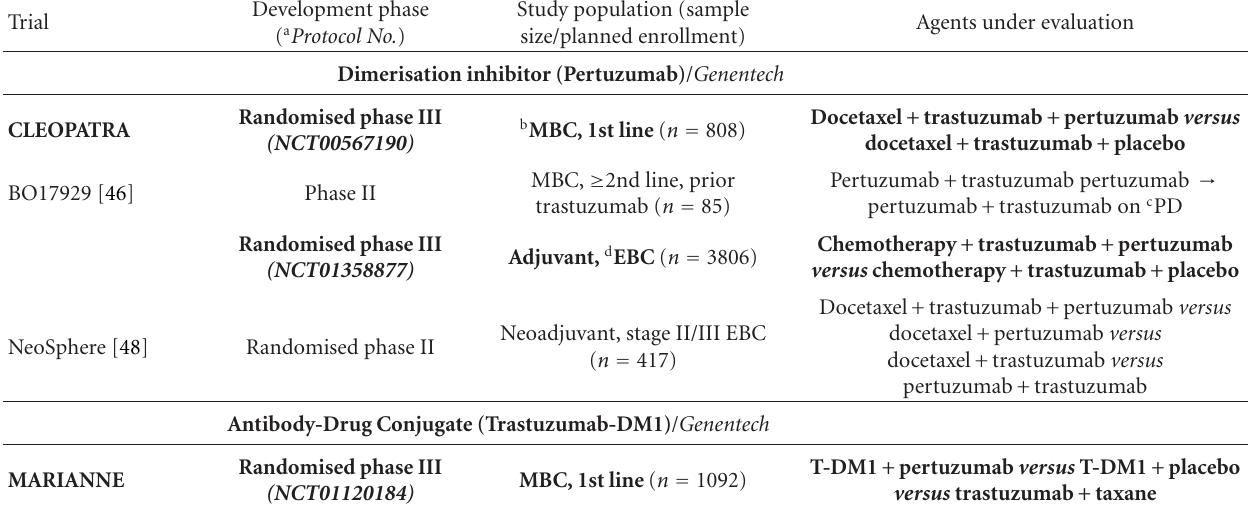
Table 1: Pertinent clinical trials of novel HER2-directed therapies in HER2-positive breast cancer. Development Trial